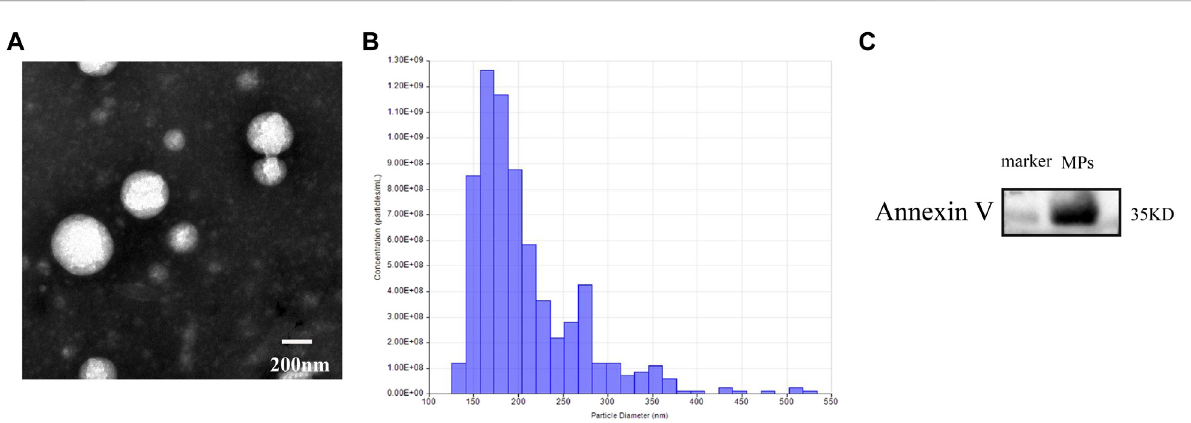
FIGURE 1 (A) transmissionelectronmicroscopicimagesofMPs. (B) nanoparticletrackinganalysisshowingtheparticledistributionofdifferentsizeofMPs. (C) western blot analysis showing the biomarker of